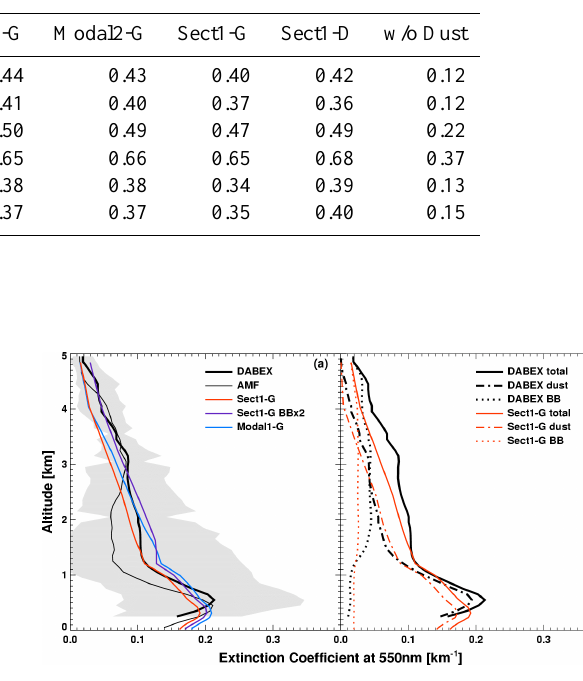
Figure 9 (a) Aerosol extinction (at 550 nm) profiles from the DABEX aircraft measurements, AMF lidar retrievals, and the WRF-Chem simulations in different cases for the DABEX period in the vicinity of Niamey. The gray area represents the standard deviation of the DABEX measurements; (b) aerosol extinction profiles from the DABEX measurements and Sect1-G simulations and their dust and biomass burning (BB) aerosol components.